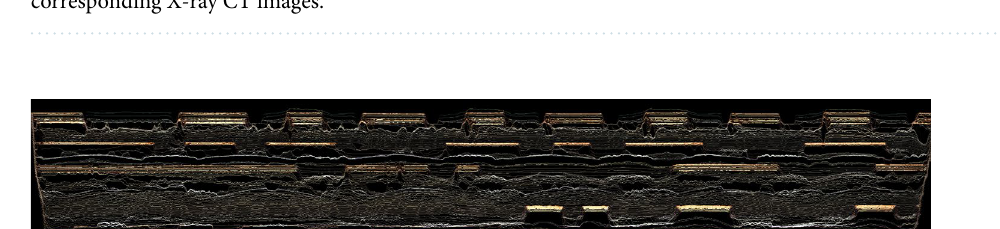
Figure 15 showcases the capability of the method for segmenting the resulting 3D image based on the ablation rate information. The left image of Fig. 15 is a heat map of the ablation rate, where red and yellow correspond